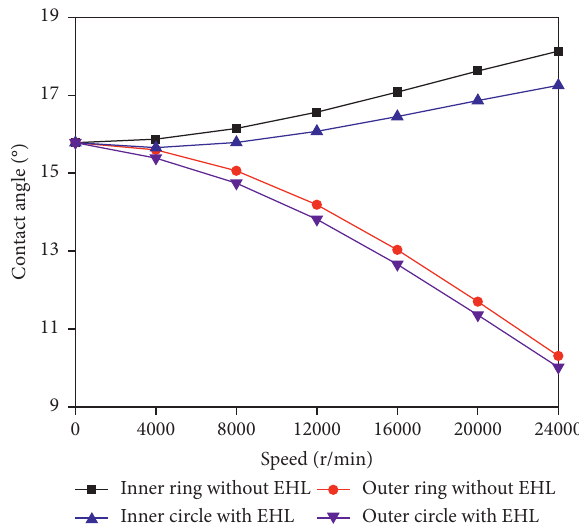
Figure 12: Influences of the speed and EHL on contact angle.